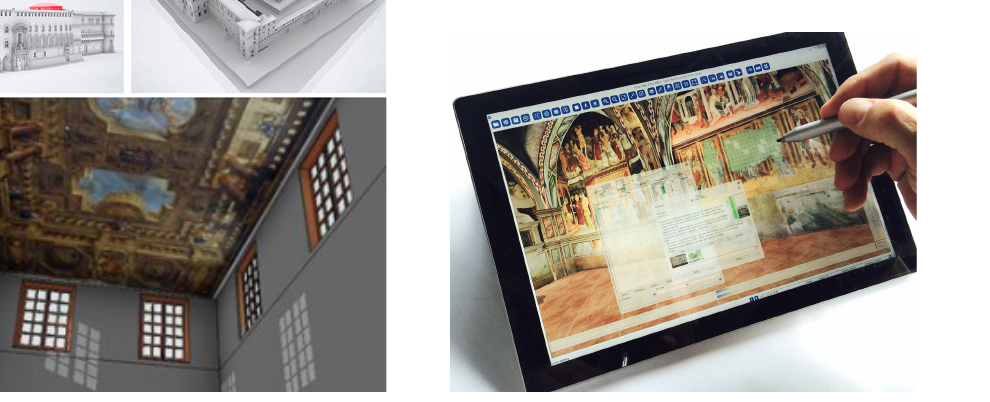
Figure 9. HBIM (Revit - Autodesk)